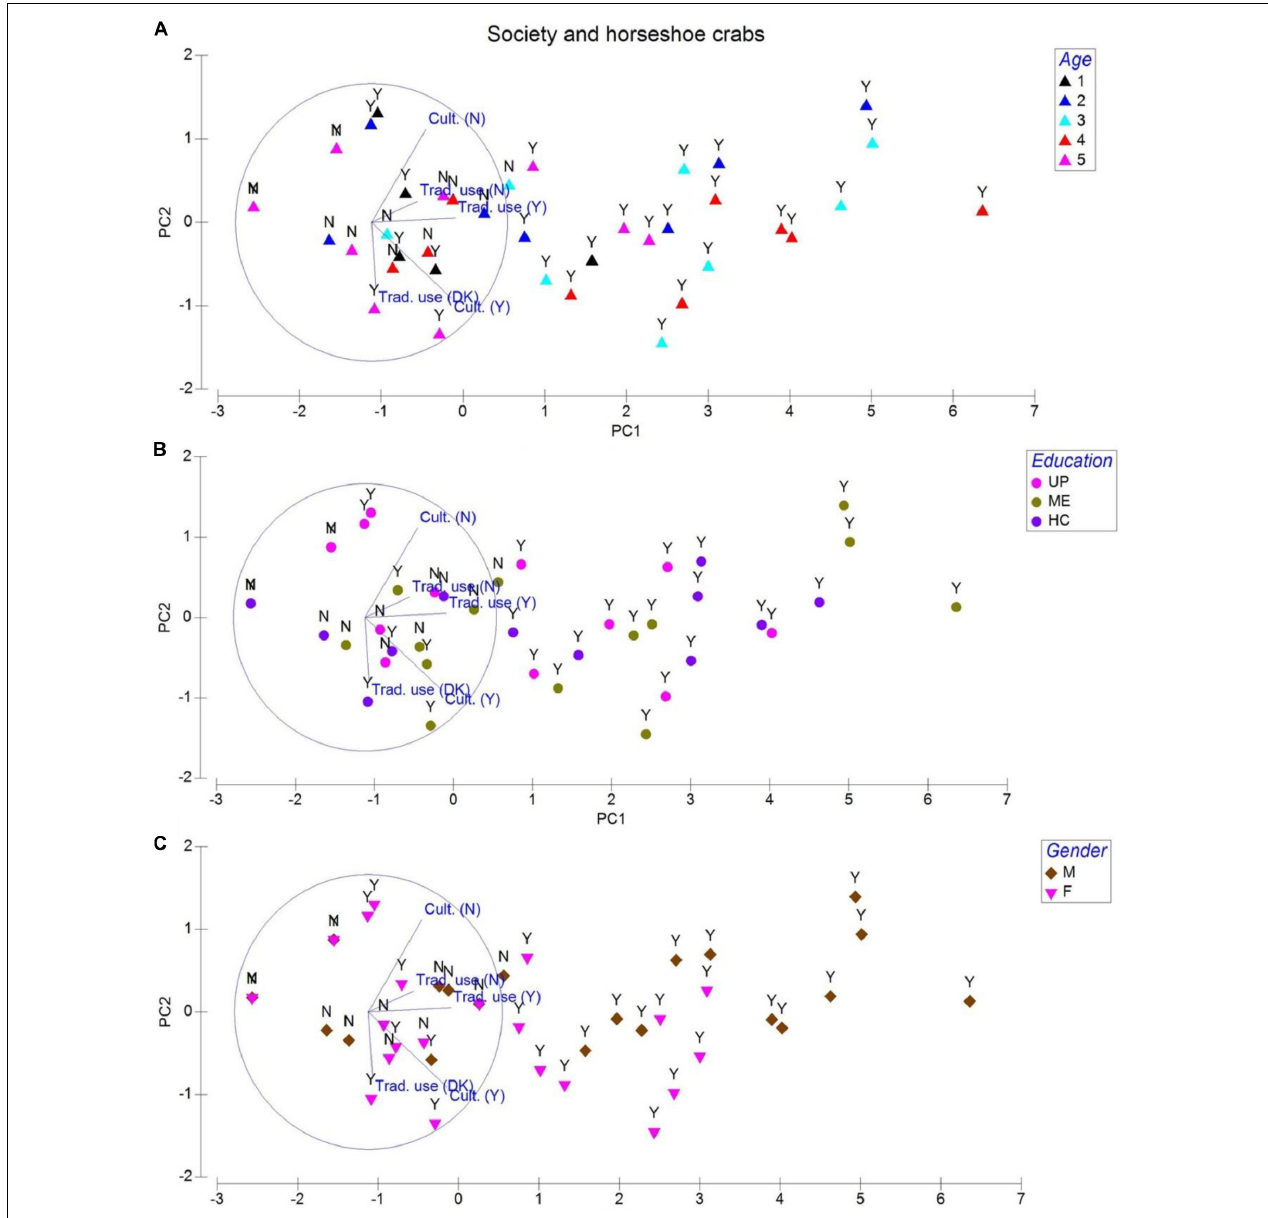
FIGURE 2 | Principal component analysis for society interaction (beliefs) and the horseshoe crab Tachypleus gigas . Abbreviations cult. = culture, Trad. use = traditional use, Y = yes, and N = no are components of the questionnaire that are assigned with values like 1 = yes and 0 = no to develop this analysis. Legends represented by age are 1 = 18–24(Group 1), 2 = 25–34 (Group 2), 3 = 35–44 (Group 3), 4 = 45–54 (Group 4), and 5 = 55–64 (Group 5). Education is denoted with UP = upper primary, ME = middle elementary, and HC = high school. Gender is represented by M = male and F = female